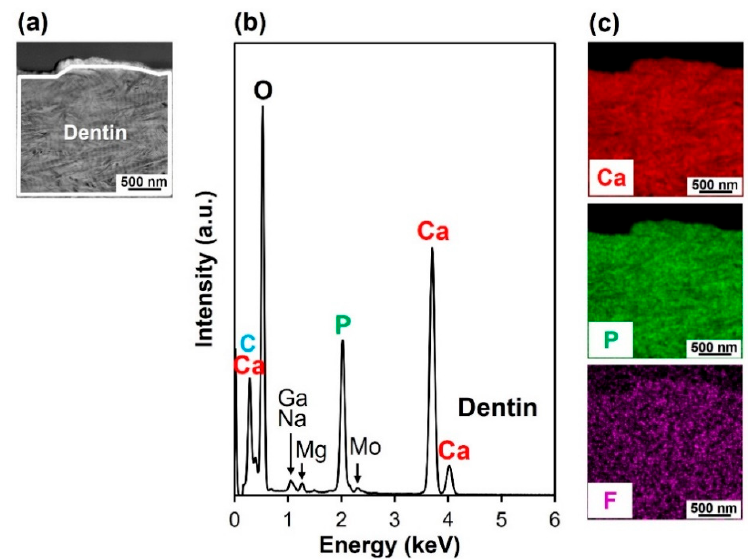
Figure 5. ( a ) Cross-sectional HAADF-STEM image of the surface of the untreated substrate, ( b ) STEM-EDX spectrum obtained from the boxed region in ( a ), and ( c ) STEM-EDX elemental (Ca, P, F) maps of ( a ).